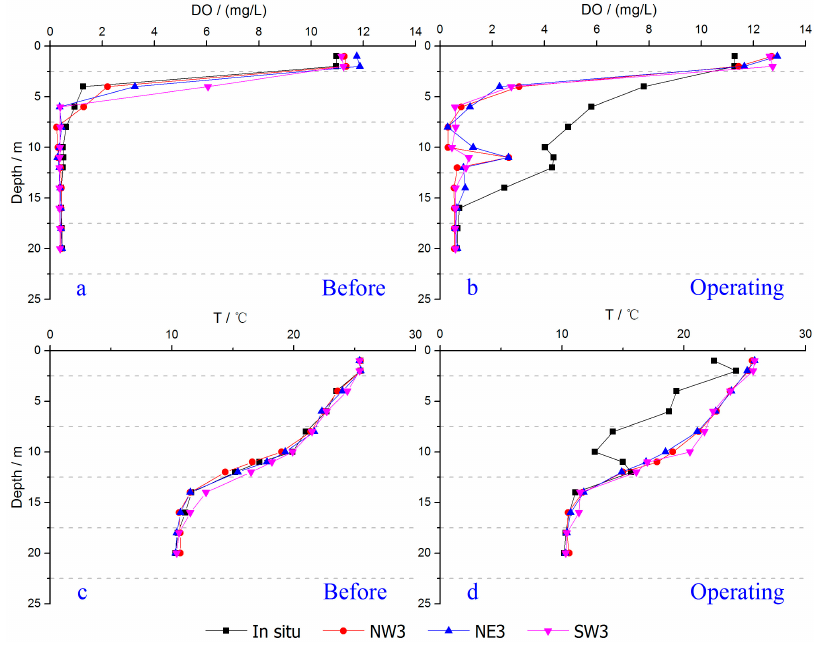
Figure 6. Variations of DO ( a ) before and ( b ) during operation of the apparatus, and T ( c ) before and ( d ) during operation of the apparatus in the water column during stratification.